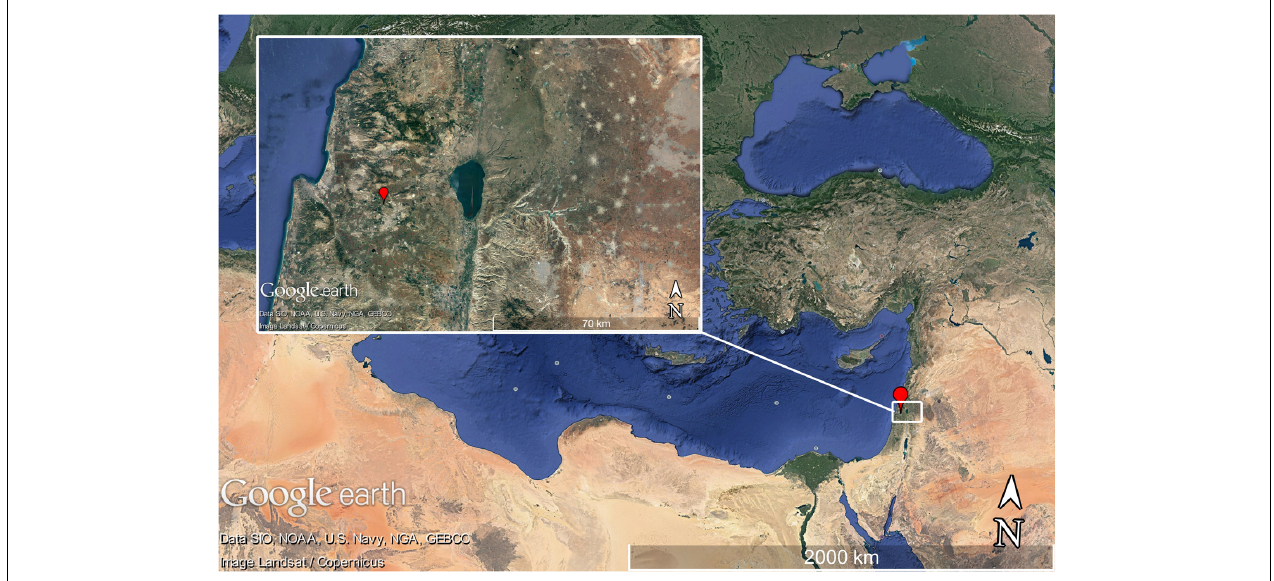
FIGURE 1 | Larger map of the Mediterranean (scale bar of 2000 km); inset: map of the sampling region in northern Israel, marking the location of the site, Zippori, in red (scale bar of 70 km). Maps generated by Google Earth.